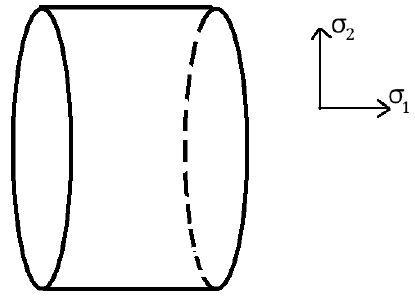
Figure 1 . An annulus in which (cid:27) 1 parametrizes an interval and (cid:27) 2 parametrizes a circle describes an open string propagating in the (cid:27) 2 direction, or a closed string propagating in the (cid:27) 1 direction, known as the crossed channel. The closed string states that contribute all have L 0 = L 0 , since the annulus is invariant under rotation of the circle parametrized by (cid:27) 2